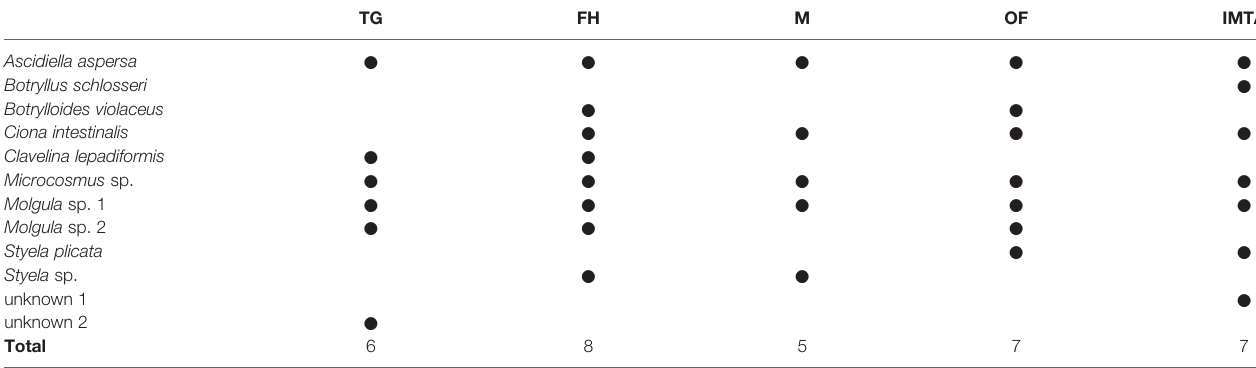
TABLE 1 | Presence/absence table of the collected ascidians throughout the duration of the experiment and their respective location within Ria de Aveiro. TG